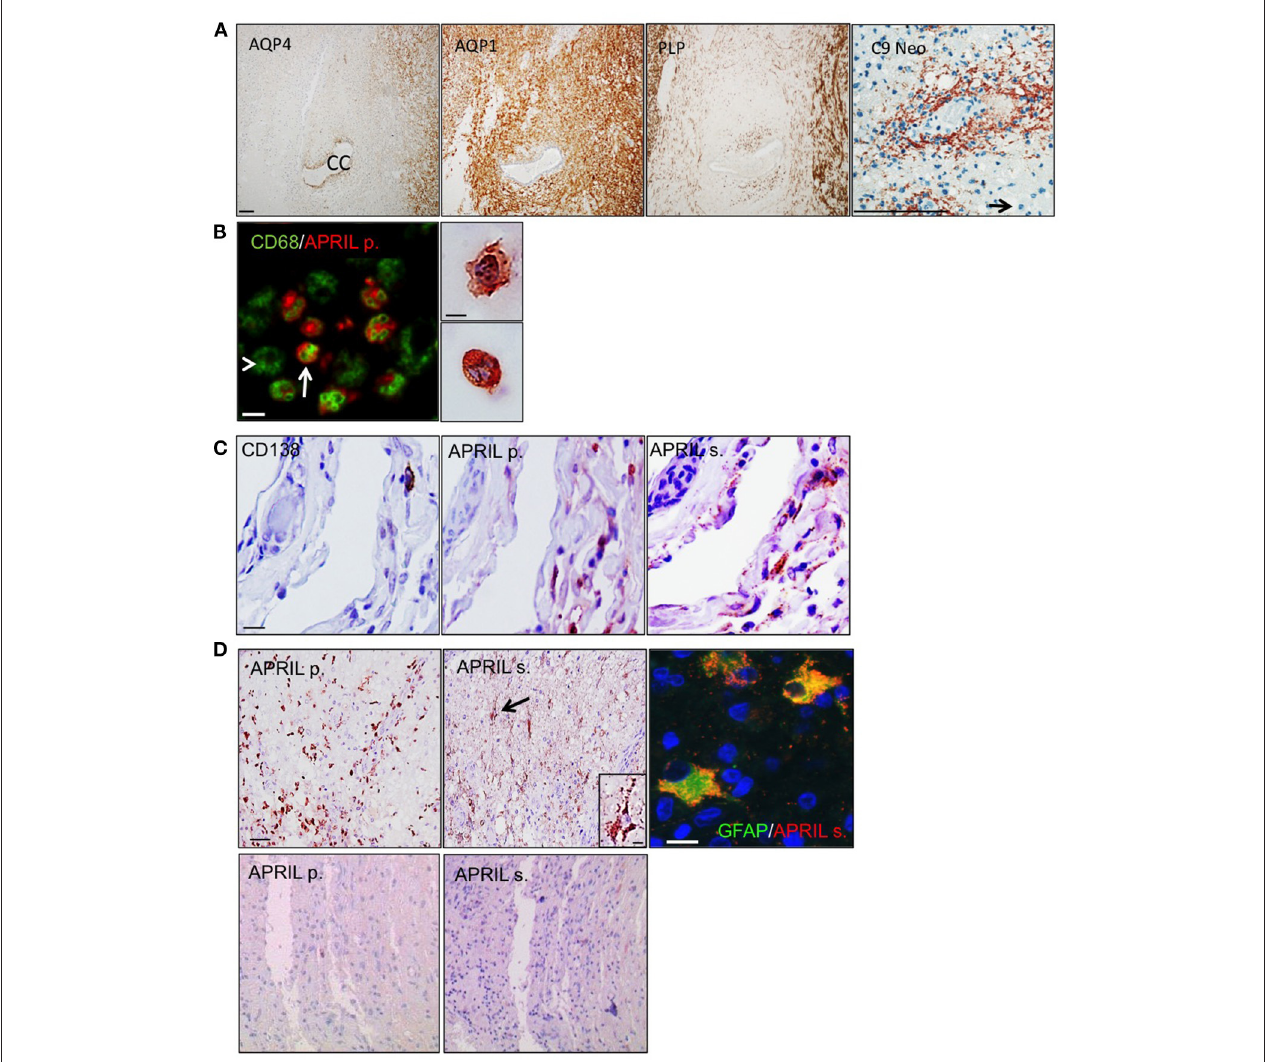
FIGURE 1 | APRIL targets reactive astrocytes in NMO lesions. Serial sections of a NMO biopsy harboring an active lesion were immunostained. (A) shows a widespread loss of aquaporin 4 (AQP4) associated to preservation of aquaporin 1 (AQP1), and proteolipid protein (PLP)-positive myelin sheaths. A vasculocentric (rosette-like) deposition of activated complement (C9 neo) is observed in an active lesion area rich in polymorphonuclear cells (scale bar = 100 µ m). The central canal (CC) of the spinal cord and a polymorphonuclear cell (arrow) are indicated. (B) shows merge stainings for CD68 + myeloid cells and APRIL-producing cells (APRIL p.) (scale bar = 10 µ m). Arrow and arrowhead mark APRIL + and APRIL − CD68 + myeloid cells, respectively. Right panel shows a high magnification of APRIL-producing cells with a macrophage (top figure) and polymorphonuclear (bottom figure) morphology (scale bar = 5 µ m). (C) shows in meninges associated to the lesion stainings for plasmocytes (CD138), APRIL p. and secreted APRIL (APRIL s.) (scale bar = 10 µ m). Upper panels (D) show in the parenchyma stainings for APRIL p. and APRIL s. (scale bar = 100 µ m). Cells binding APRIL with a morphology of astrocytes are arrowed, showed in the high magnification insert (scale bar, 5 µ m), and identified by GFAP costaining (scale bar = 5 µ m). Lower panels (D) show an area outside lesions of the spinal cord stainings for APRIL p. and APRIL s. (scale bar 100 µ